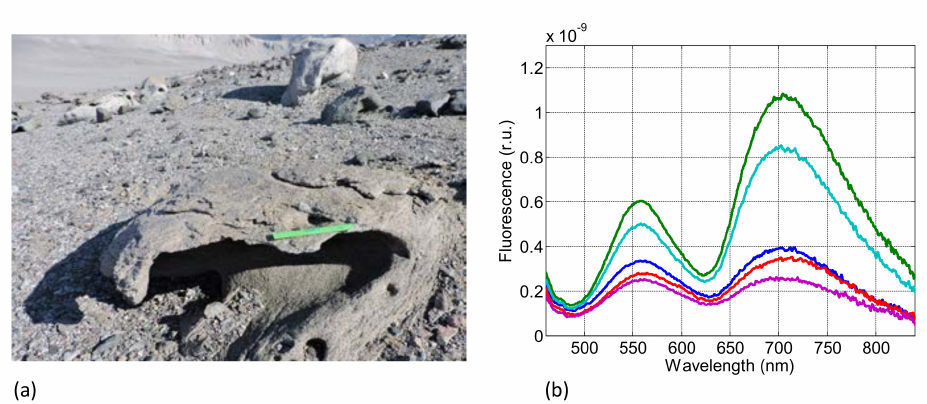
Figure 6. LIF spectra on a weathered magmatic rock (Lake Joyce area, Dry Valleys, Antarctica). ( a ) Magmatic rock on which the LIF spectra were acquired. ( b ) LIF spectra acquired in different spots of the rock